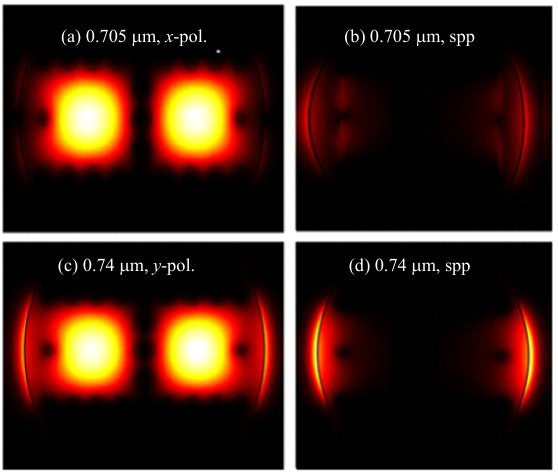
Fig. 3 Optical field distribution of the proposed biosensor: (a) x - and (c) y -polarized fundamental modes and (b) x - and (d) y -polarized SPP modes for analyte RI of